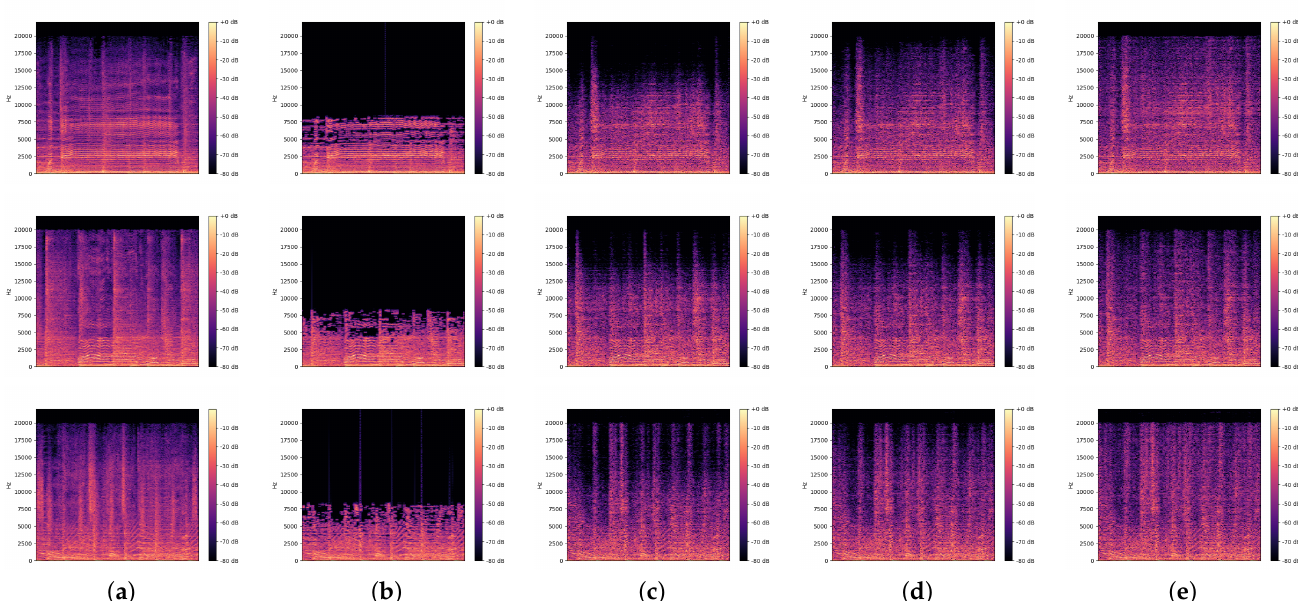
Figure 3. Spectrograms of ( a ) original audio excerpts, ( b ) corresponding 32 kbit/s MP3 versions, and ( c – e ) restorations with different noise z randomly sampled from N ( 0, I )